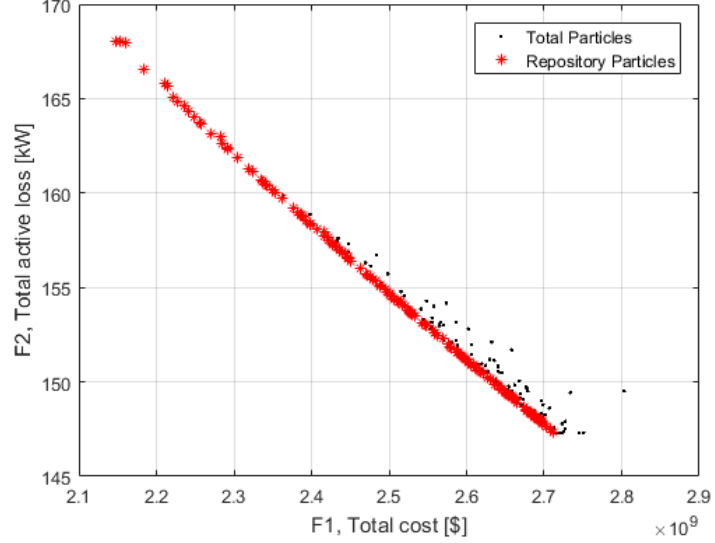
Figure 7. Pareto optimality (Scenario